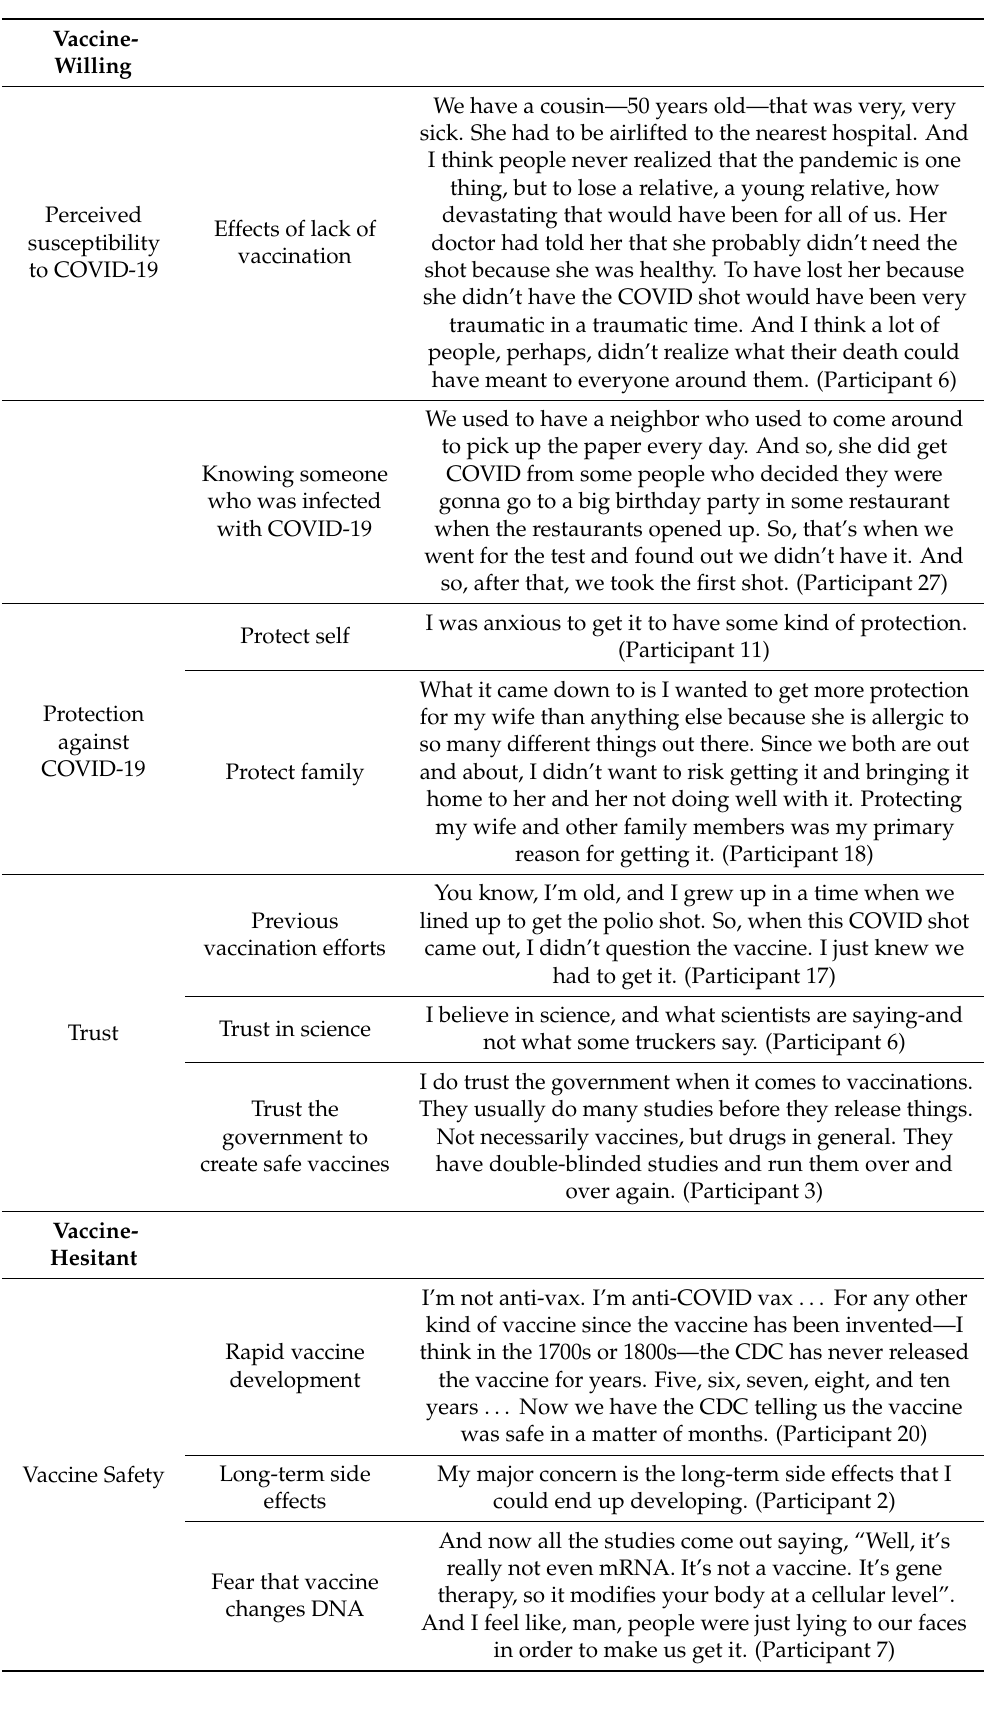
Table 3. Perceptions of COVID-19 vaccine-hesitant and vaccine-willing